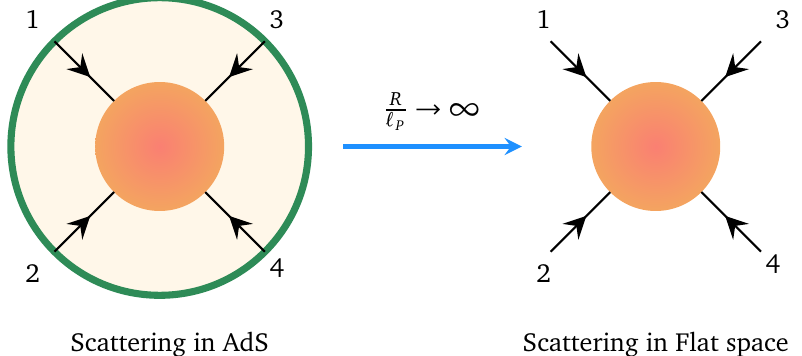
Figure 1: Transition from AdS to Flat